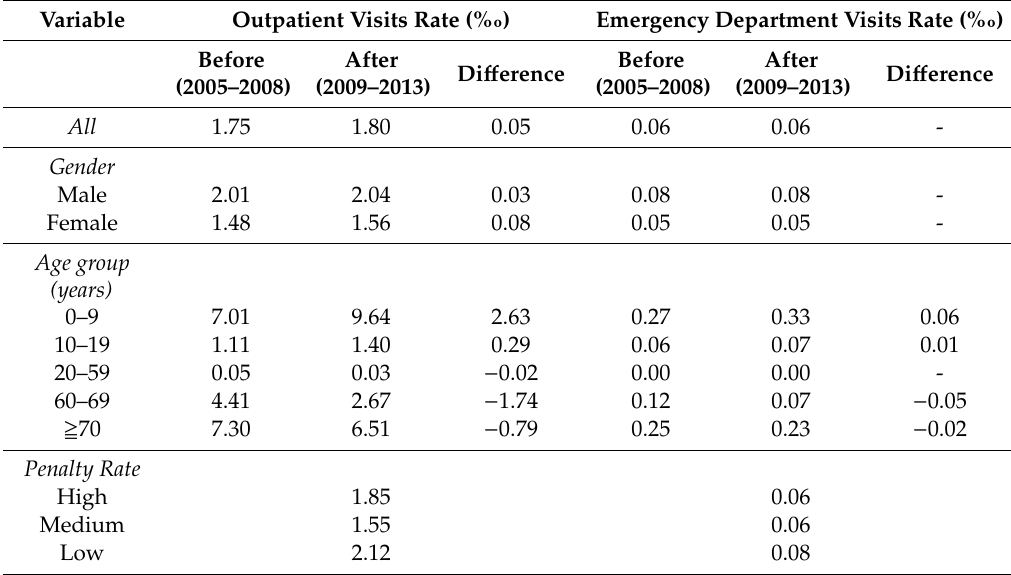
Table 3. Crude rates of outpatient and emergency department visits before and after the enactment of the